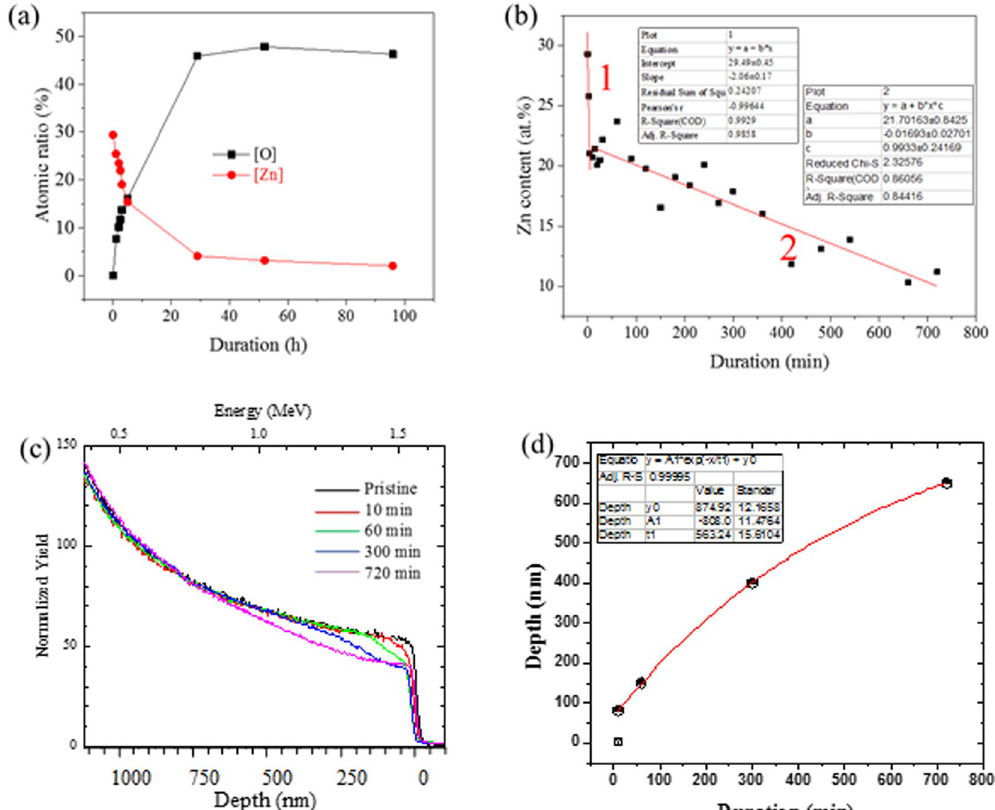
Figure 2. ( a ) The EDS analysis of [O] and [Zn] on the surface of the samples de-alloyde at 20 °C. ( b ) The Zn content of PIXE analysis plotted with duration (min). The range of fitting plot 1 is 0~10 min. The range of fitting plot 2 is 10~720 min. Pristine material CuZn30 dealloyed with 1 M NaOH at room temperature. ( c ) The RBS analysis on dealloyed CuZn30. Dealloyed with 1 M NaOH at room temperature. ( d ) Penetrated depth of oxide layer plotted against the process duration and fitted with polymer equation. The penetrated depth of oxide layer was set at 0.5 μ